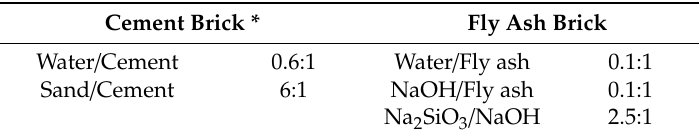
Table 2. Mix formulation one